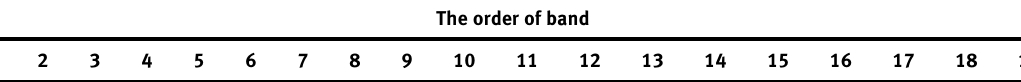
Table A  : Parities at high symmetry points of the band structures for UC n A and UC n B.